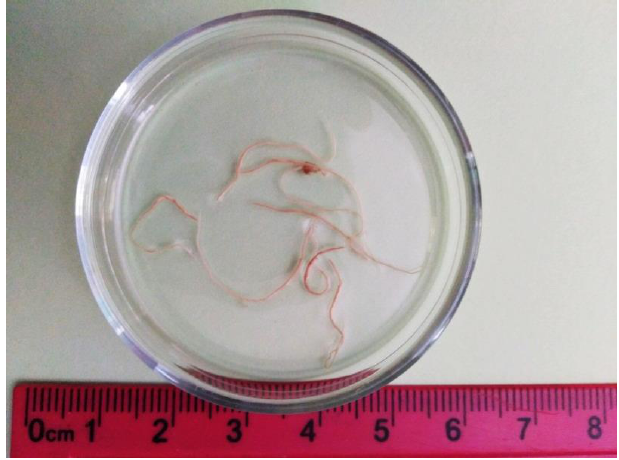
Fig. 1. The appearance of the imagine forms of helminths of the species H. contortus